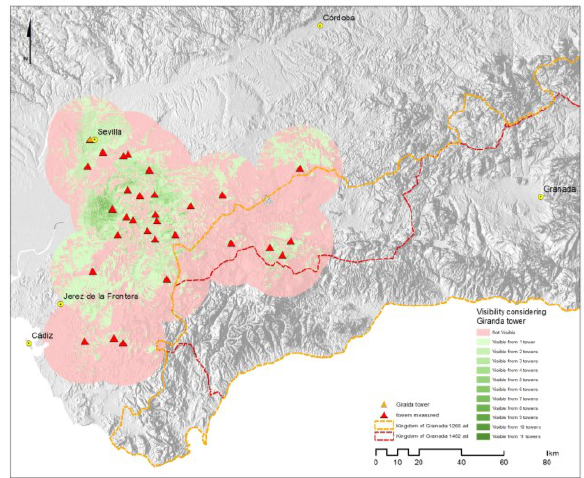
Figure 6: Visibility study from the towers, considering a limited distance of 20km, the earth´s curvature and the Giralda